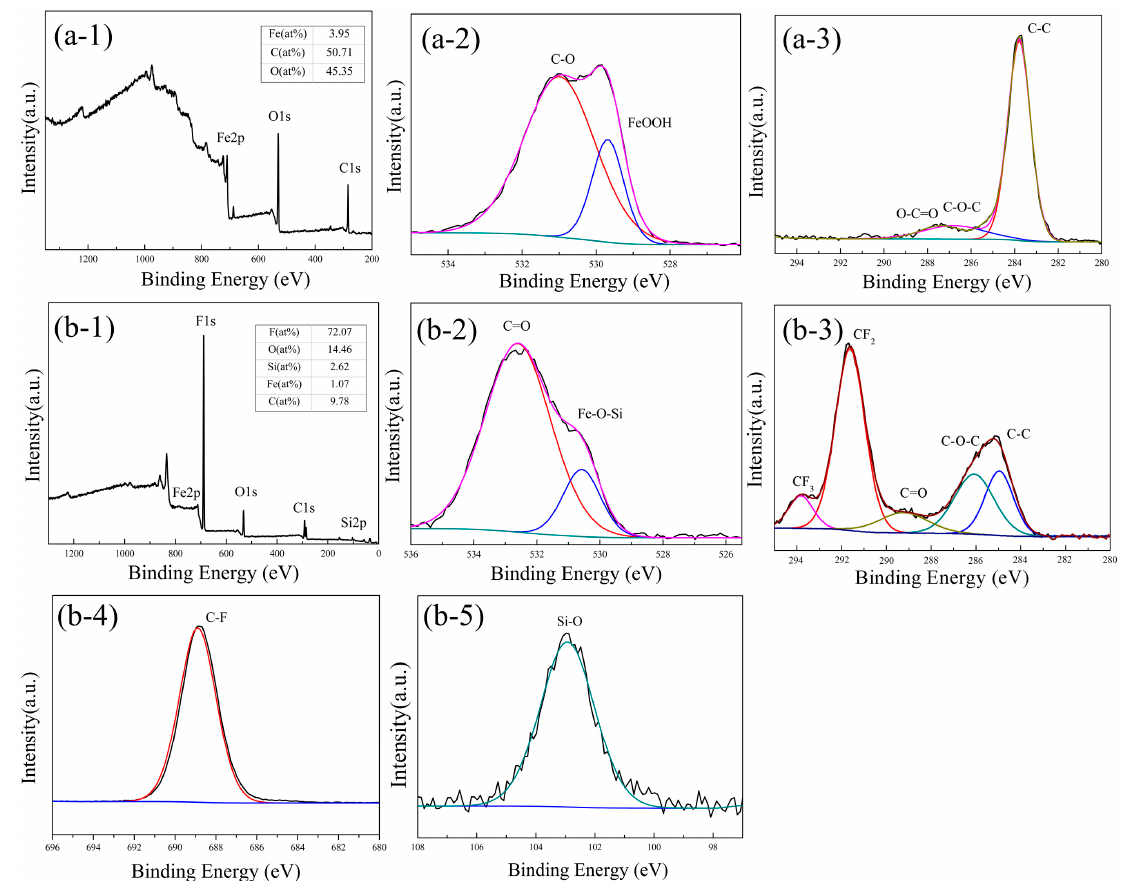
Figure 3. XPS spectra detected from structured Q235 carbon steel surface: the XPS survey spectra (